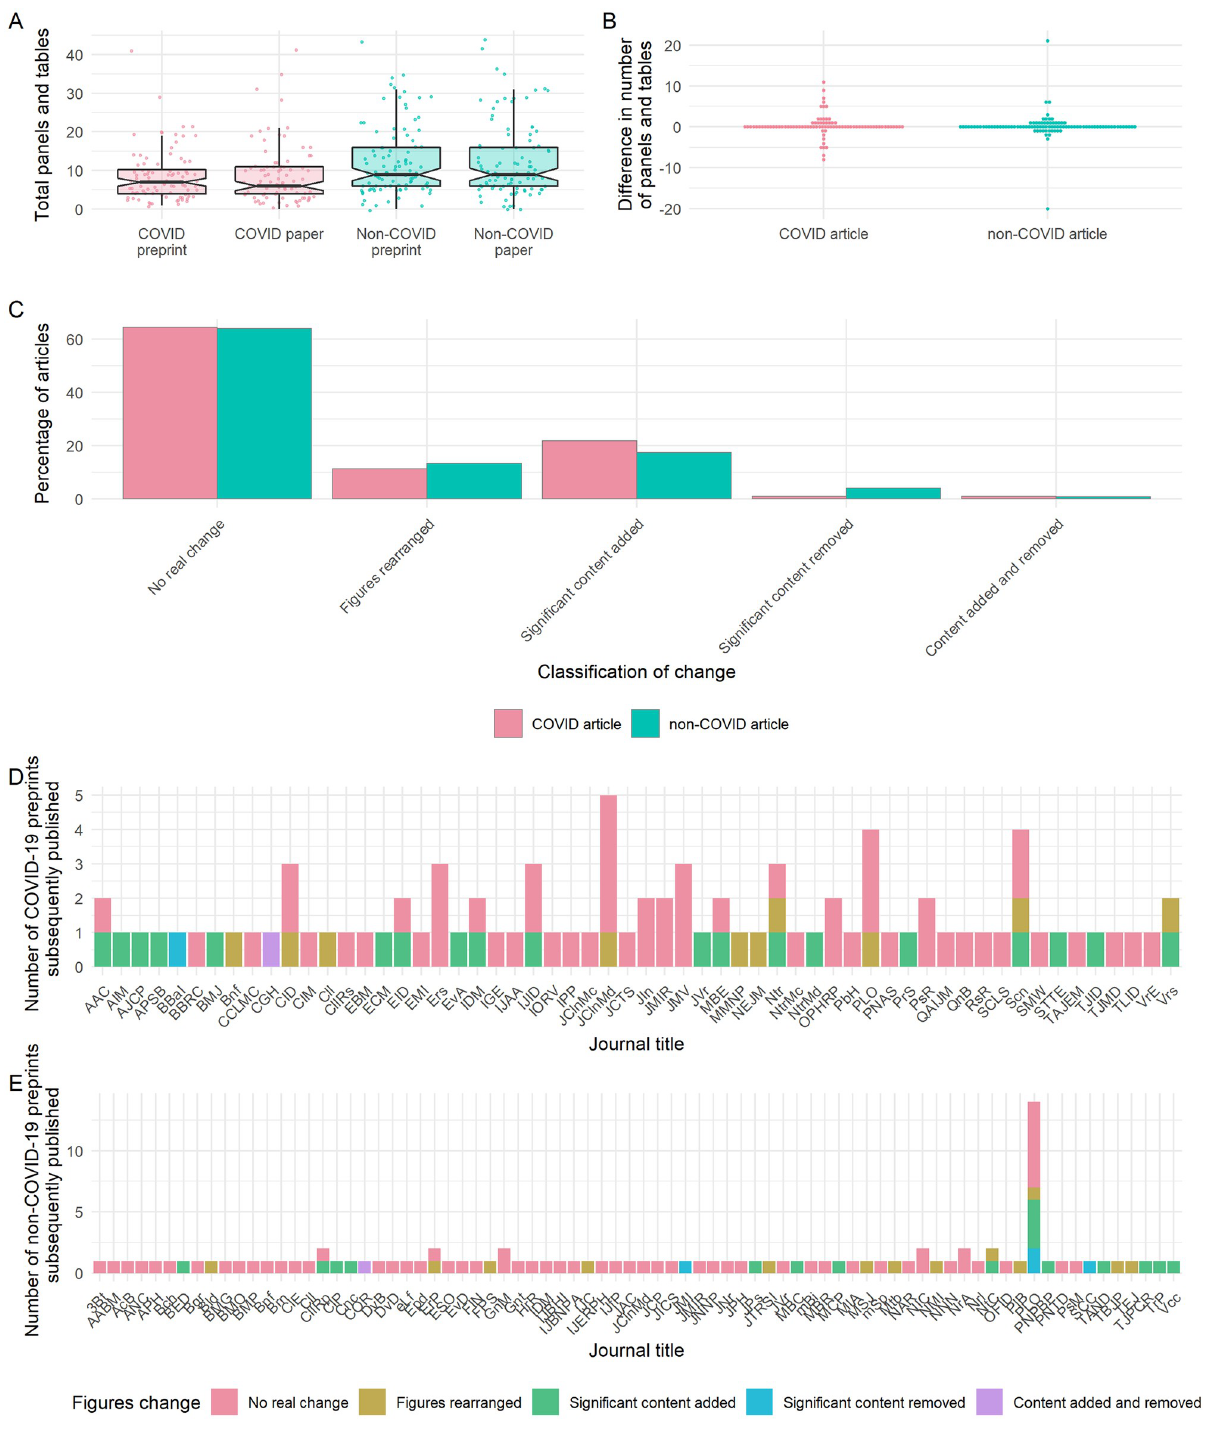
Fig 2. Preprint–publication pairs do not significantly differ in the total numbers of panels and tables. (A) Total numbers of panels and tables in preprints and published articles. Boxplot notches denote approximated 95% CI around medians. (B) Difference in the total number of panels and tables between the preprint and published versions of articles. (C) Classification of figure changes between preprint and published articles. (D) Journals publishing COVID-19 preprints, based on annotated changes in panels. (E) Journals publishing non-COVID-19 preprints, based on annotated changes in panels. All panels describe sample of preprints analysed in detail ( n = 184). See S1 Text for key to abbreviated journal labels. The data underlying this figure may be found at https://github.com/preprinting-a-pandemic/preprint_changes and https://zenodo.org/record/5594903#.YXUv9_nTUuU. CI, confidence interval; COVID-19, Coronavirus Disease